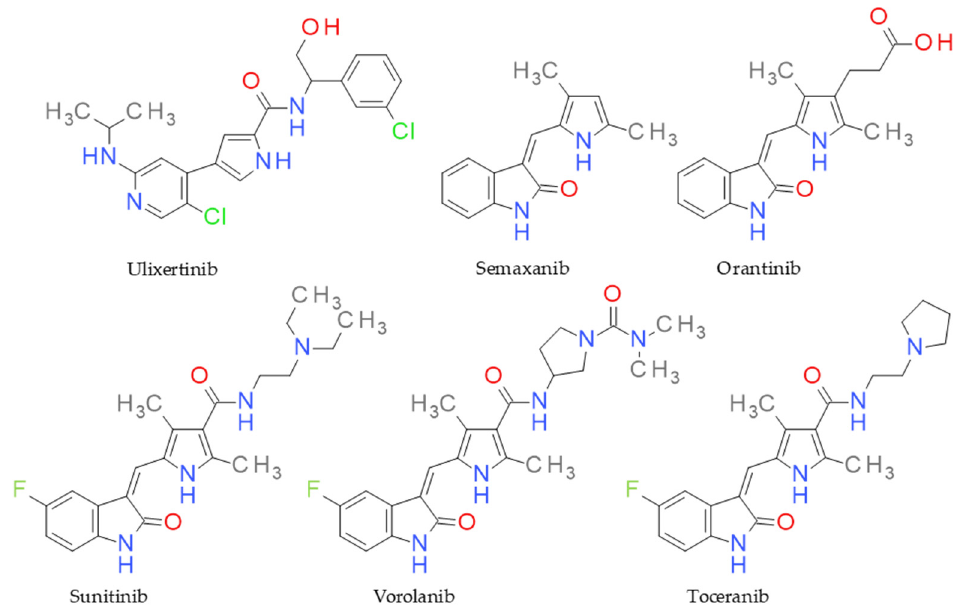
Figure 1. Structure of anticancer drugs sharing the pyrrole ring.